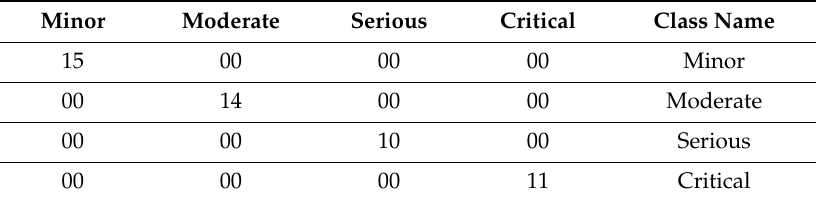
Table 19. Confusion Matrix for fold 3.